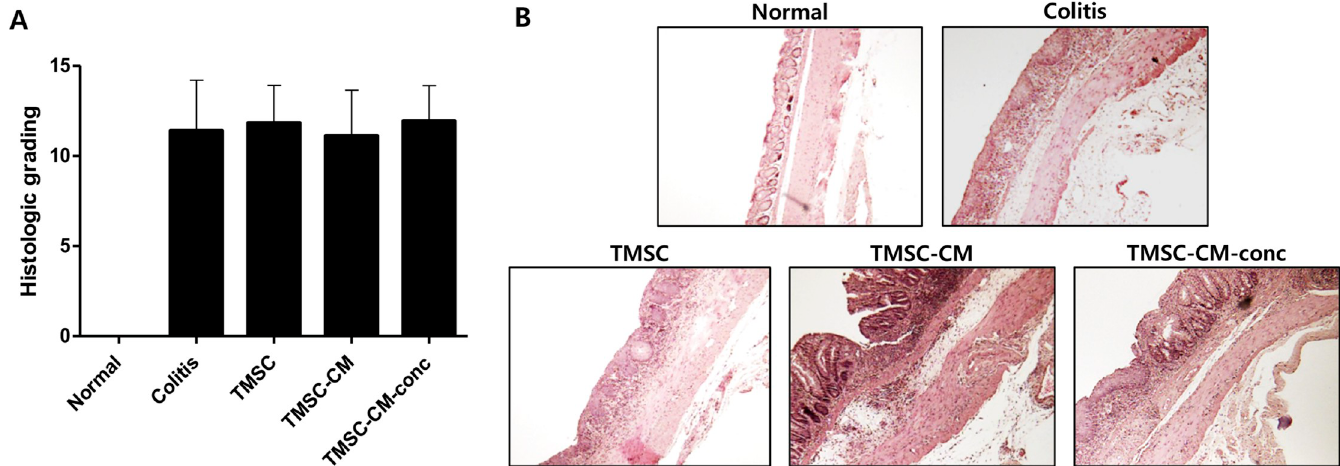
Fig 7. Histopathological alteration. (A) Histologic colitis scoring did not show significant difference between each of groups. (B) Histopathologic findings of distal colon of each group are shown. (Hematoxylin-eosin (H&E) stain, 100x).